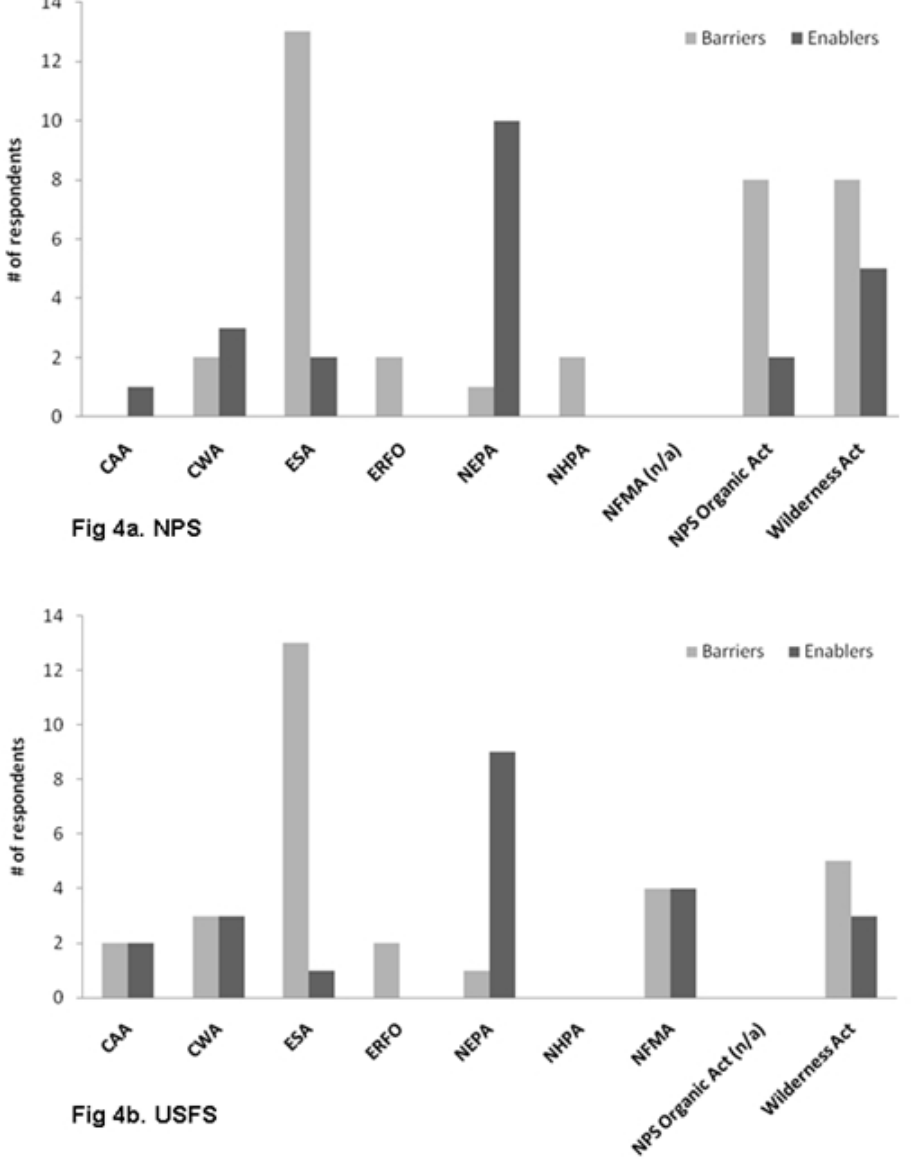
Fig. 4 . NPS and USFS interviewee responses regarding effect of key federal laws on